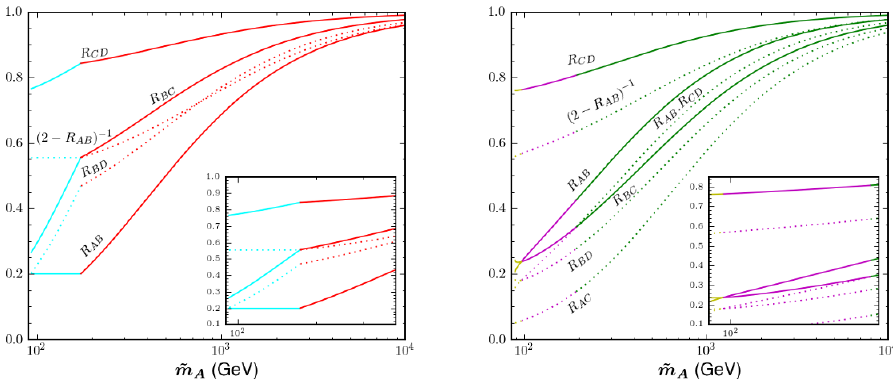
Figure 17 . The equivalent representation of (cid:12)gure 16 in terms of the mass squared ratios R R BC and R CD (solid lines). The dotted lines depict various quantities of interest which are used to delineate the regions in (cid:12)gure 2. The left panel shows the true branch passing through regions (3 ; 2) (cyan) and (3 ; 1) (red), while the right panel shows the auxiliary branch through regions (4 ; 2) (yellow), (4 ; 3) (magenta) and (2 ; 3) (green). The left insert zooms in on the transition between regions (3 ; 2) and (3 ; 1) near ~ m A = 173 GeV, while the right insert focuses on the transitions between regions (4 ; 2) and (4 ; 3) near ~ m A = 97 GeV and between regions (4 ; 3) and (2 ; 3) near ~ m A = 193 GeV.